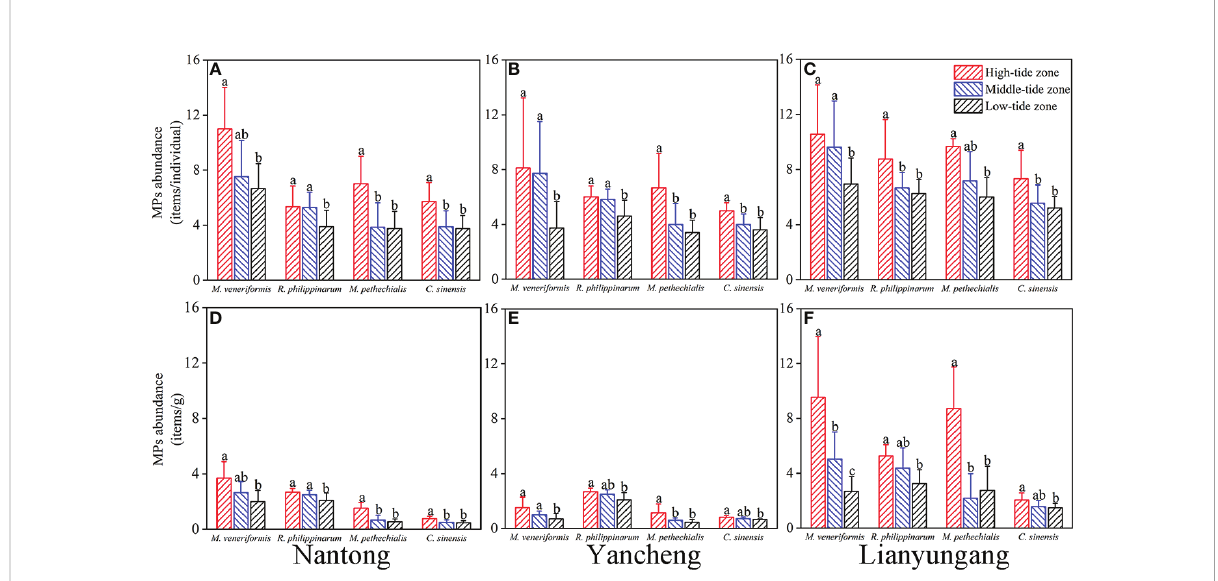
FIGURE 2 Abundance of MPs (mean ± SD) in different tide zones (high-tide zone, middle-tide zone and low-tide zone) of four species of clams from different sites in three intertidal zone of South Yellow Sea normalized to items per individual (A – C) and items per gram wet weight (D – F) . Different letters above the bars indicate signi fi cant differences between tide zones of the same species in the same area (One-way ANOVA, P <